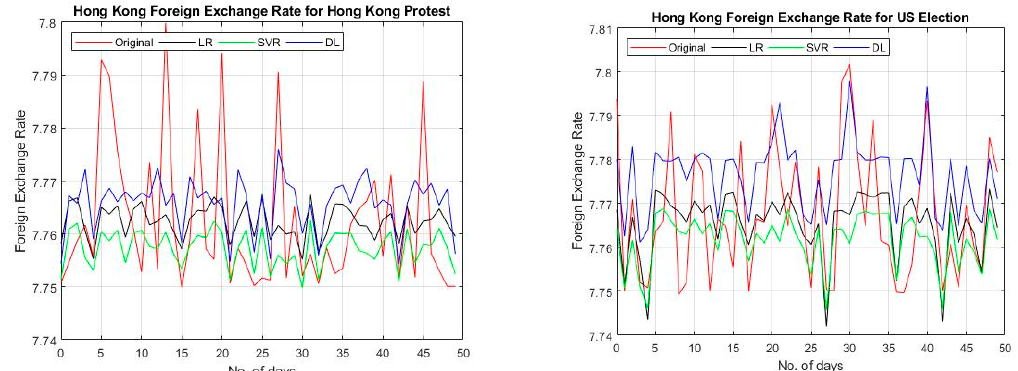
Figure 4. The plot of 50 forecasted and actual values of the foreign exchange rate of Hong Kong